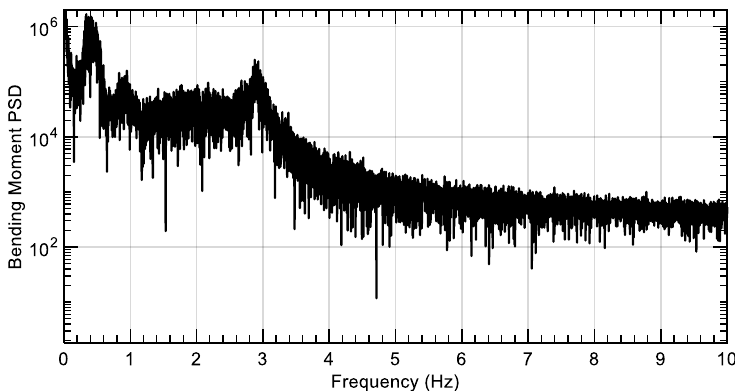
Figure 31. Frequency analysis, tower-base bending moment, turb. class B.